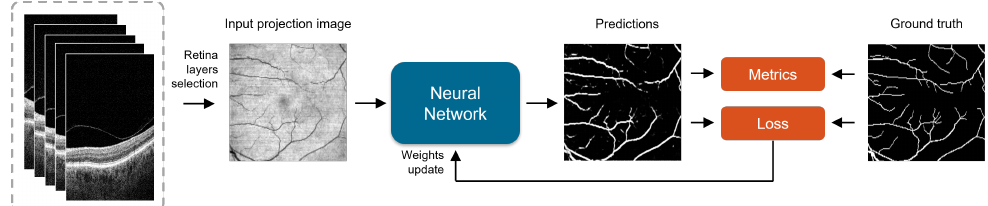
Figure 5. The general overflow of the proposed